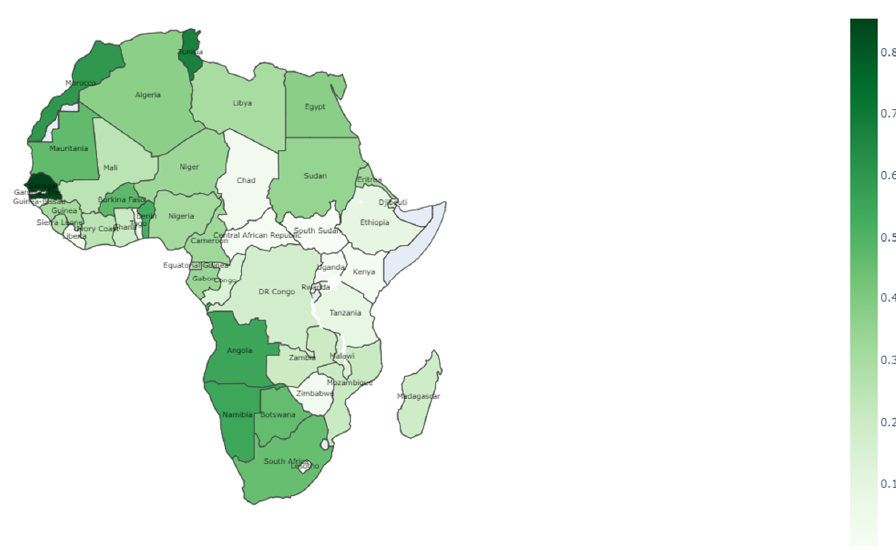
Figure 3. Cumulative results for values of synthetic sustainable growth indices for the studied African countries in 2010–2018—a standardization model that breaks down all terms in the series by their initial values (a). Source: own work.